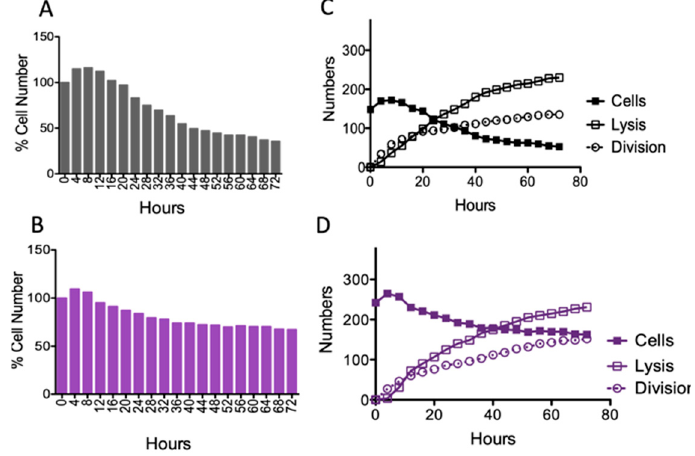
Figure 6. Quantitative single-cell analysis. The cumulative behavior of ( A ) wild-type M. smegmatis and ( B ) the msm2570::Tn mutant cells in the presence of 50 µg/mL INH exposure. The number of cytolyzed and divided cells are shown for ( C ) wild-type M. smegmatis and ( D ) the msm2570::Tn mutant cells.